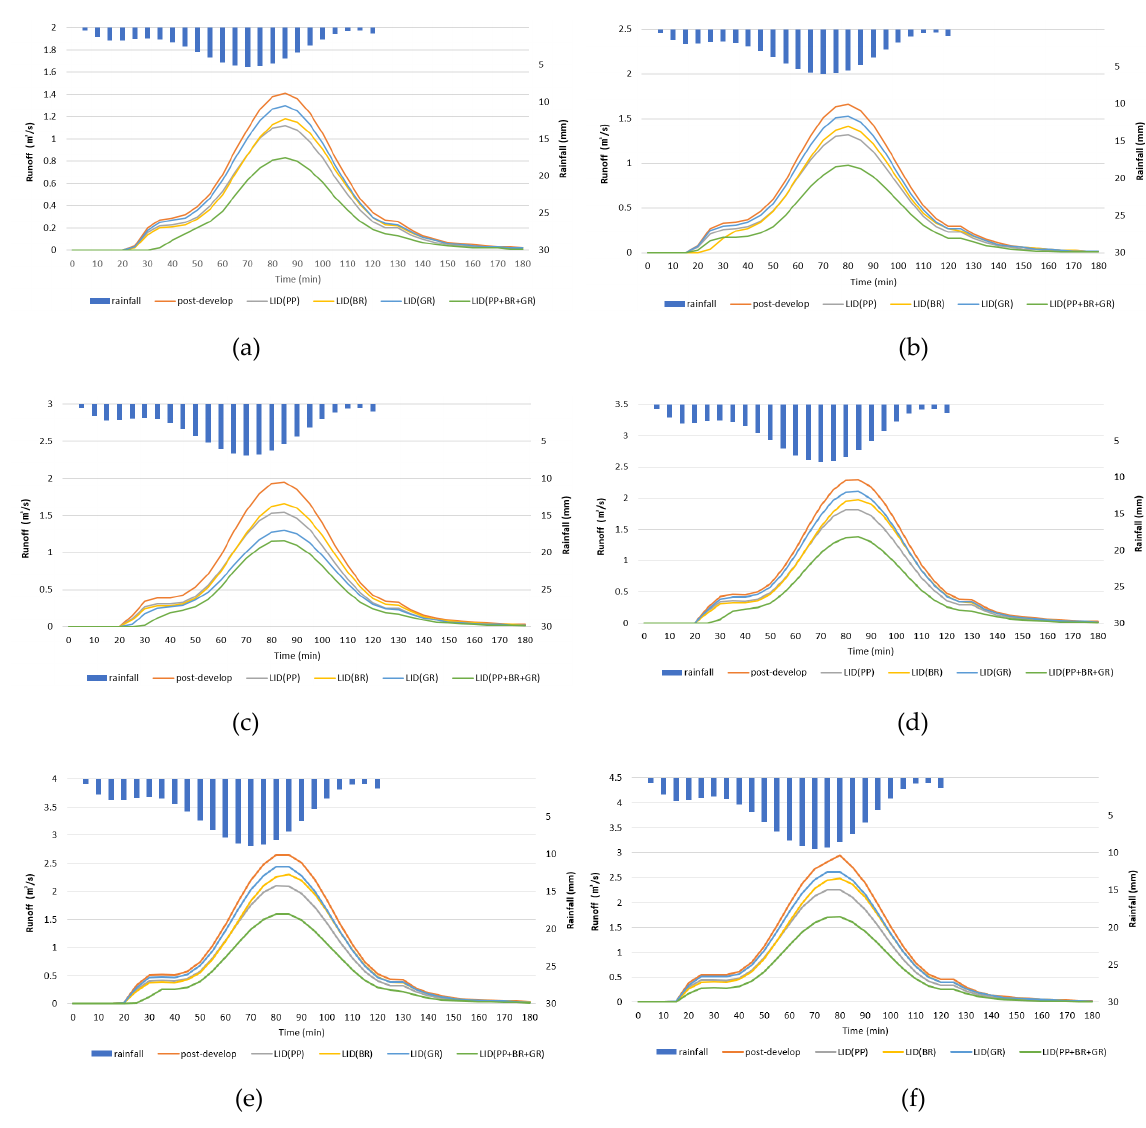
Figure 11. Rainfall and runoff under various precipitation conditions: ( a ) 2-year period, ( b ) 3-year period, ( c ) 5-year pe- riod, ( d ) 10-year period, ( e ) 20-year period, and ( f ) 30-year period. If the LID-applied areas for different LID types are different, it is challenging to per- form an objective comparison [31]. Therefore, in order to examine the LID efficacy per unit area, the amount of the runoff decrease was divided by the LID area for both the post-